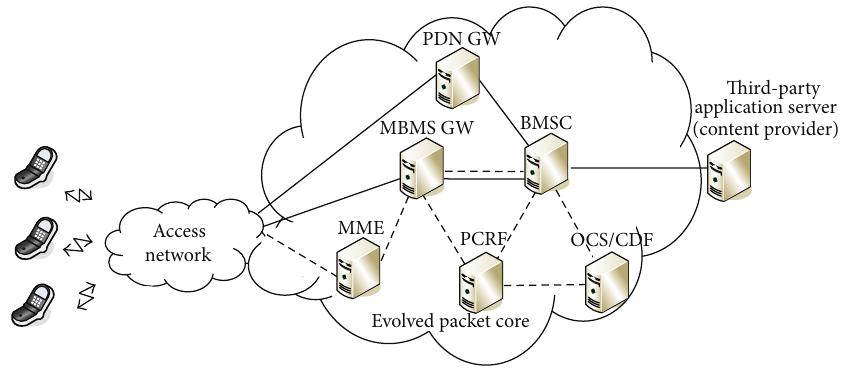
Figure 1: Reference architecture of MBMS for